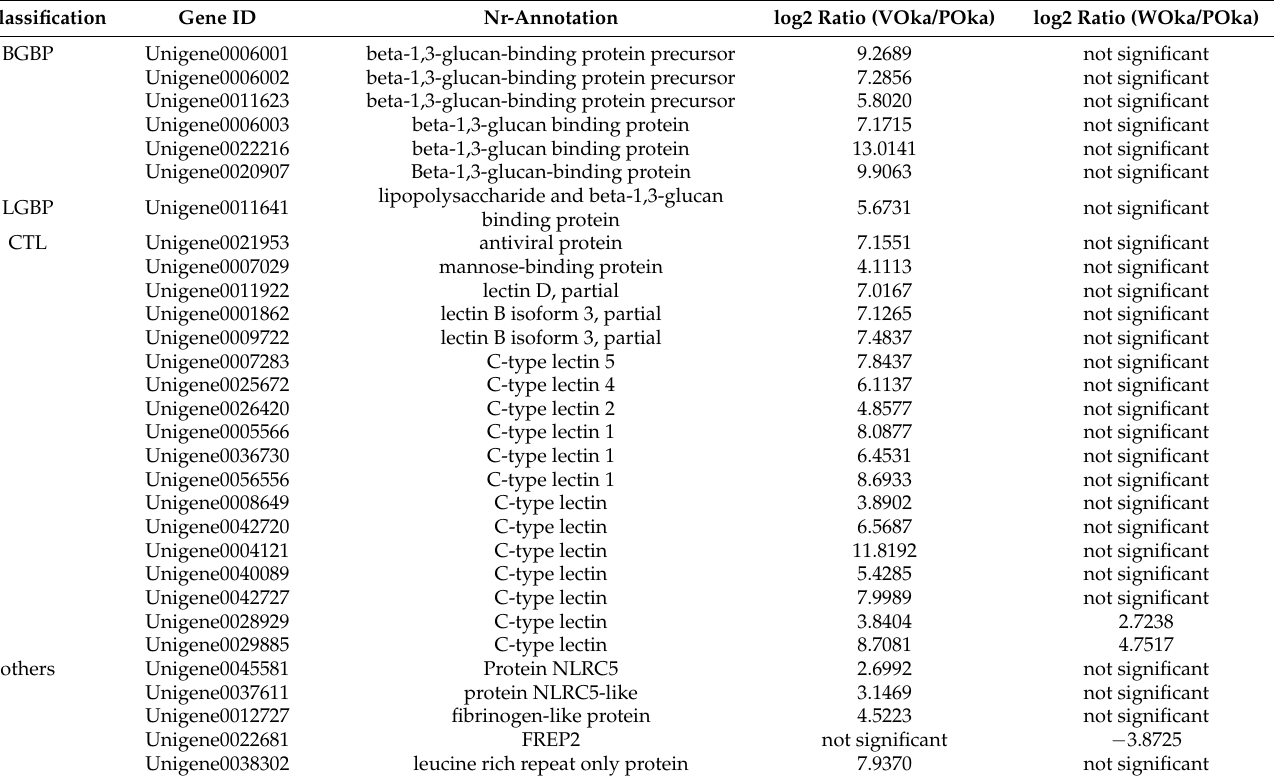
Table 2. Differentially expressed PRRs in the lymphoid organ after Vibrio or WSSV challenge.